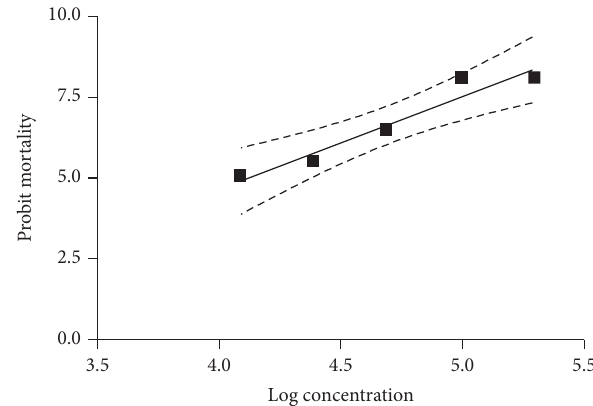
Figure 3: Regression line of probit mortality of R. ( B. ) microplus against the log concentrations of the extract of Atropa belladonna using larval packet